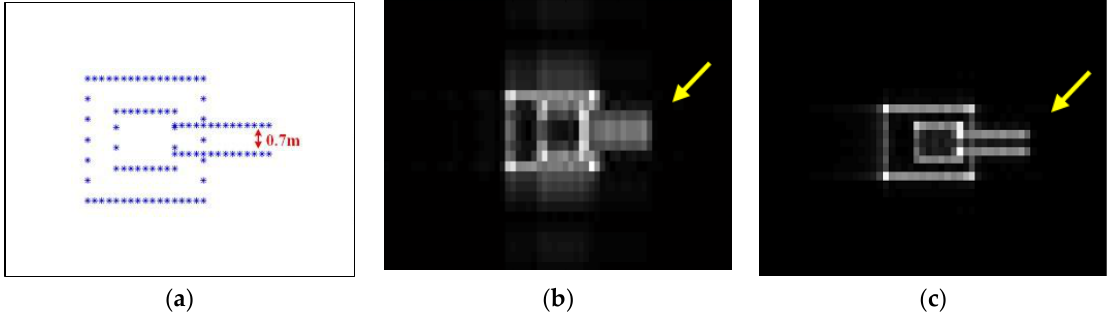
Figure 11. Multi-target simulations of the ( a ) scatterer distribution; ( b ) original single-track image; and ( c ) image processed by the azimuth super-resolution